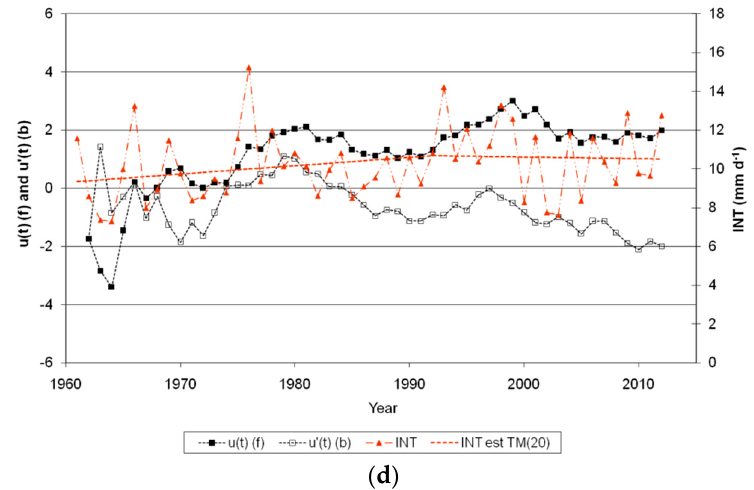
Figure 6. Annual variation of mean rainfall intensity (INT) at BO ( a ), RC ( b ), VD ( c ), and LB ( d ) between 1960 and 2012, and determination of the breakpoint from Mann–Kendall–Sneyers, where u(t) and u’(t) are the test values forward (f) and backward (b), respectively, and from Tomé–Miranda (TM) where MINIX = 15 for ( a ) and ( b ), and 20 for ( c ) and ( d ).